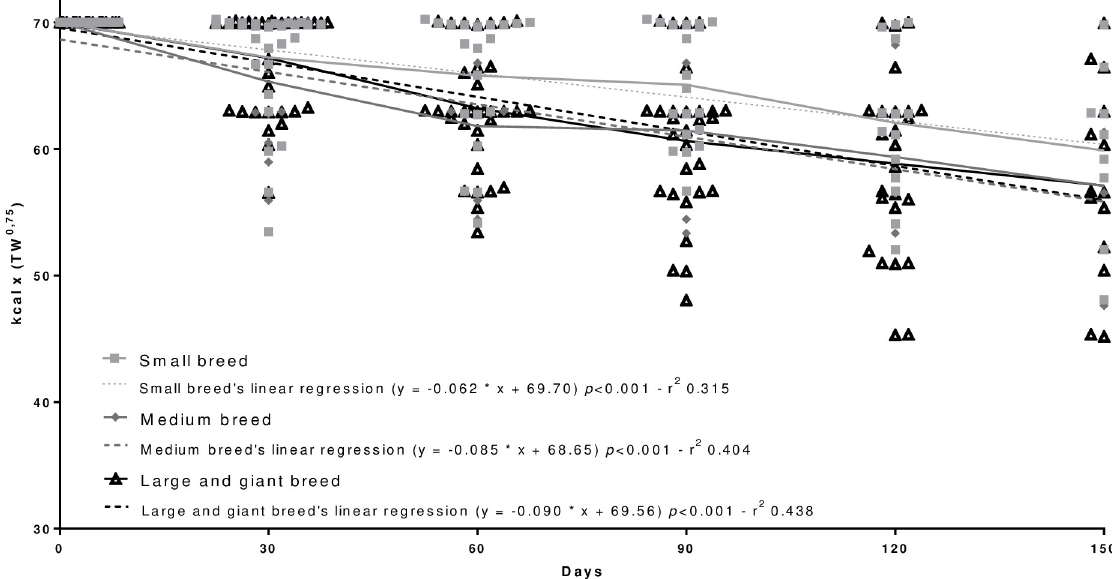
Fig 4. Regression analysis and complete distribution of the calories (kcal) applied to the weight loss equation [kcal x (TW 0.75 )] according with body size.